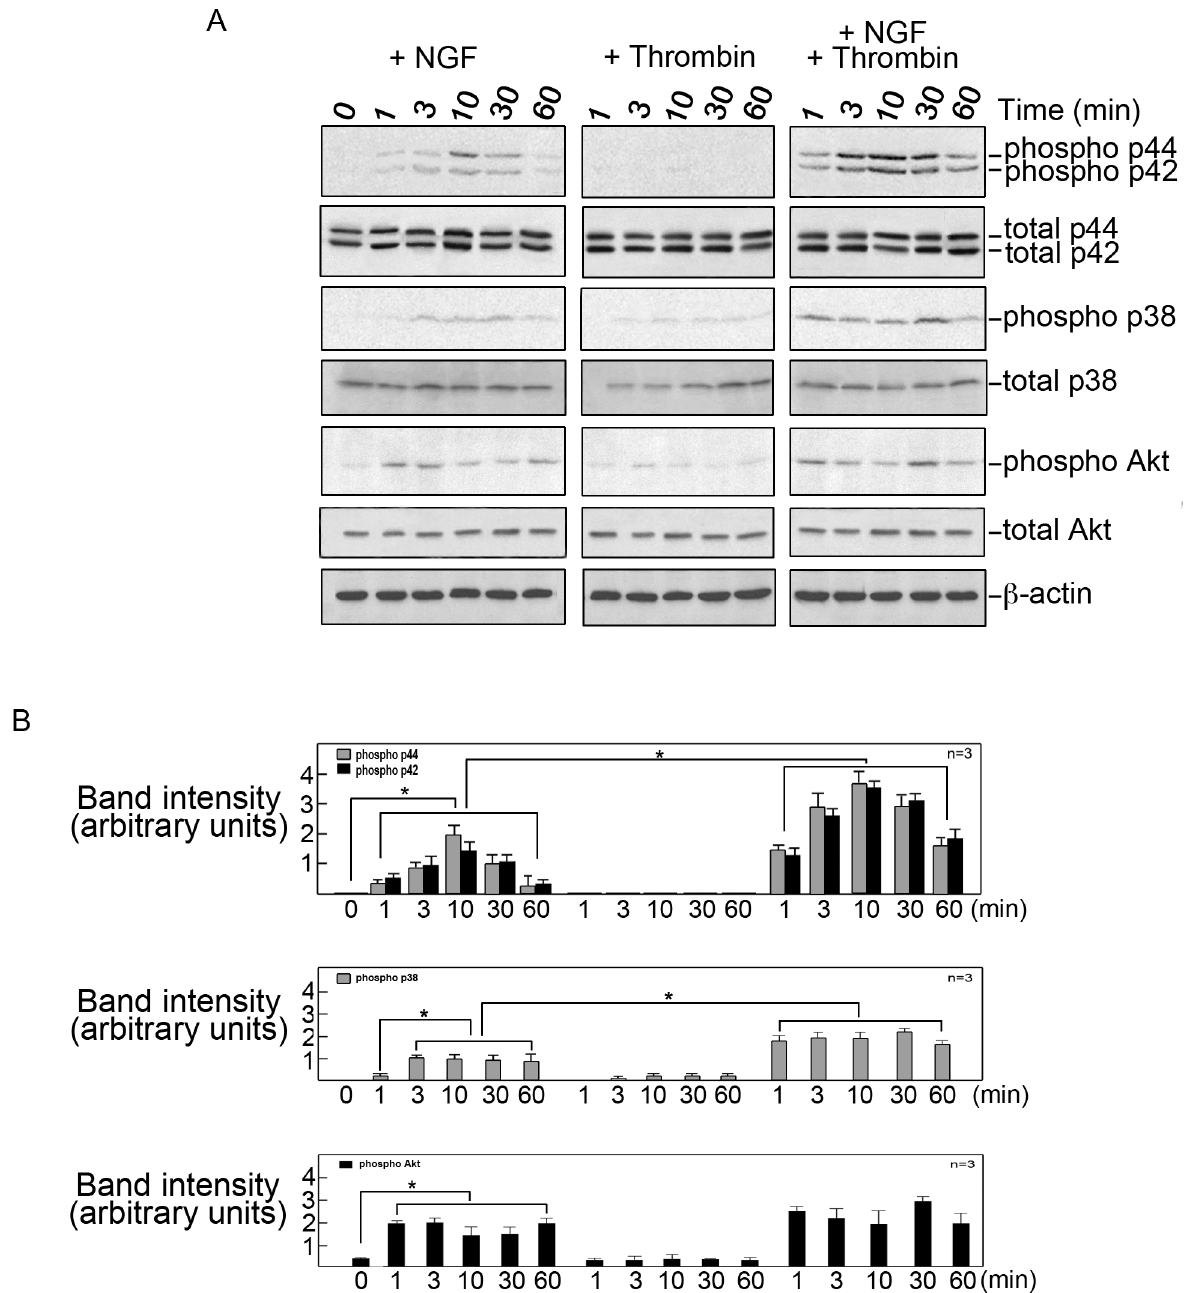
Figure 4. Thrombin enhances NGF-induced neurite outgrowth in differentiating cells via enhanced and sustained activation of p44/ 42 and p38 MAPK. A. PC12 cells were plated as described in Materials and Methods. After serum starvation for 18 hours, cells were treated with NGF alone (left panels), thrombin alone (middle panels), or NGF + thrombin simultaneously (right panels) under serum-starved conditions, and lysed at 0, 1, 3, 10, 30 and 60 minutes post-treatment. Equal amounts of protein samples were then subjected to western blot analysis using phospho- antibodies against p44/42 MAPK, p38 MAPK and AKT. Immunoblots for total amounts of these proteins were used as internal controls. Equivalent loading was assessed by immunoblotting for b -actin. B. Intensities (in square pixels) of the immunoreactive bands in (A) were measured by densitometric analysis using the NIH Image 1.61 software. Values are means 6 SD of three separate experiments and indicated by an asterisk (*). Nerve growth factor,